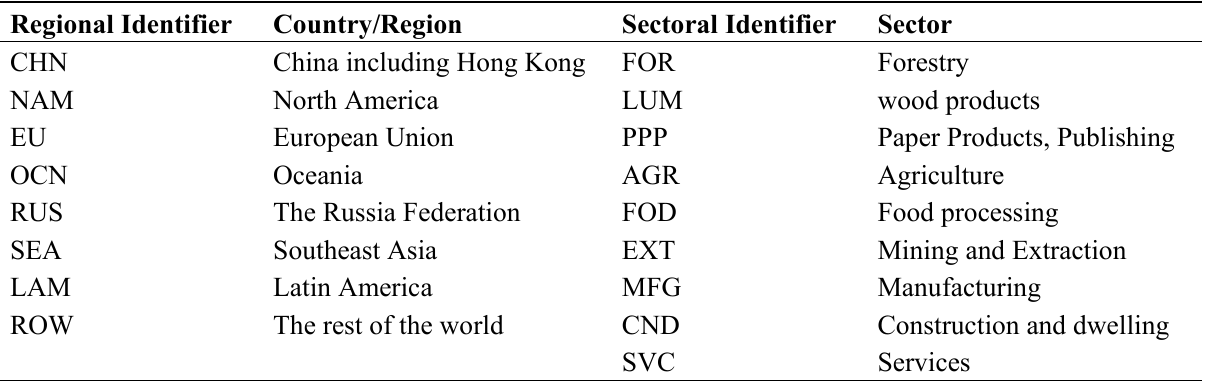
Table 2. Regional and sectoral